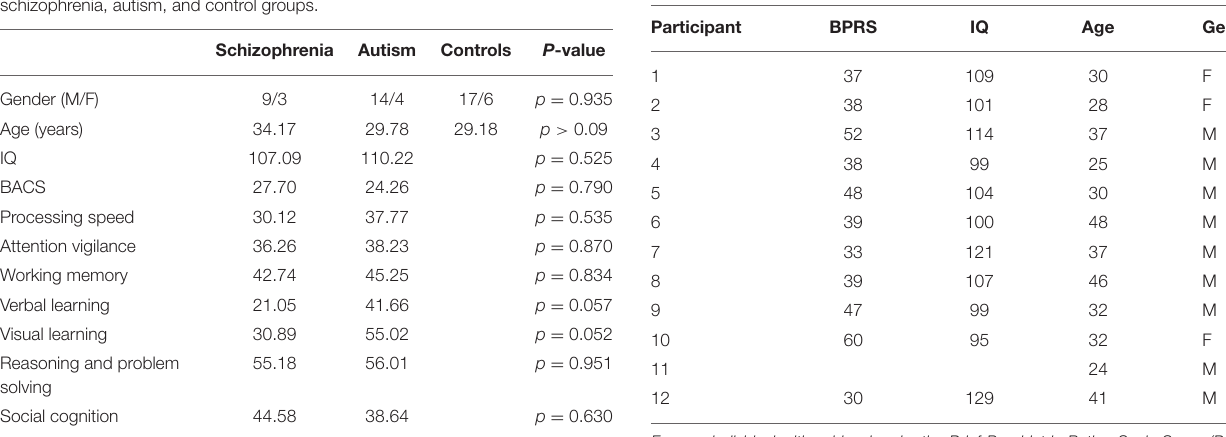
TABLE 2 | Demographic information for the schizophrenia group.